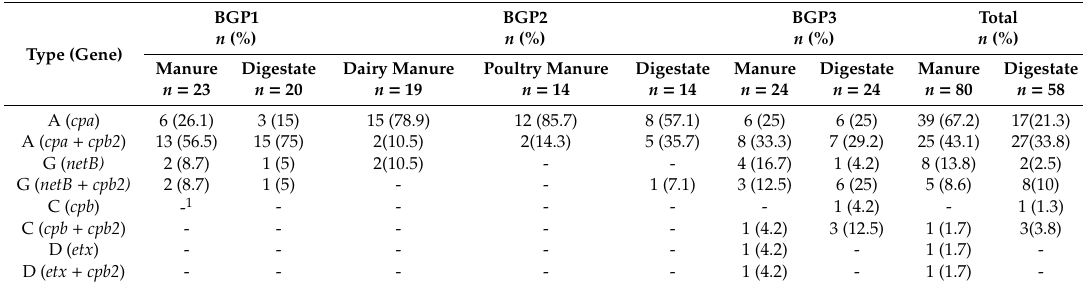
Table 3. Occurrence of the toxinotypes of C. perfringens isolates in manure and digestate in three biogas